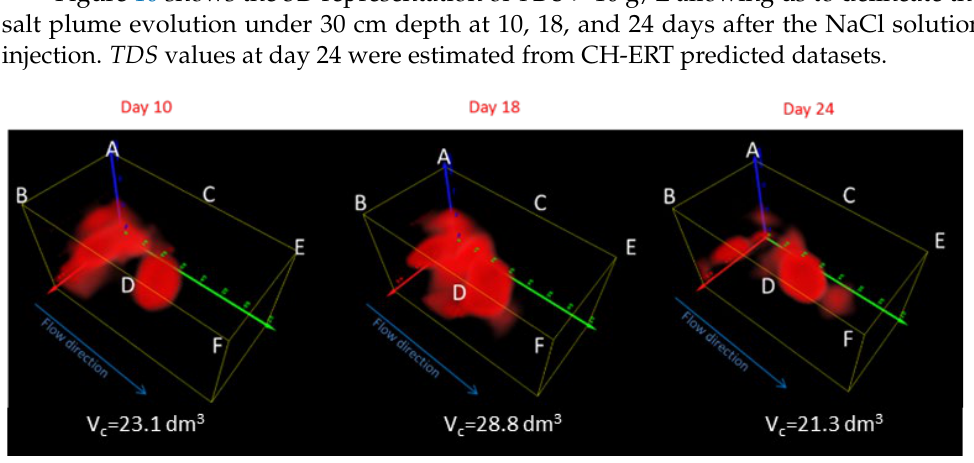
Figure 10. In red is the 3D distribution of TDS > 10 g/L obtained from predicted CH-ERT. A–F are piezometers, V c is the contaminated volume. TDS values at day 24 were estimated from CH-ERT predicted datasets. The 3D distribution was obtained with Paraview software (version 5.6.0, Kitware, Sandia National Labs, Los Alamos nat. lab., ASC and ARL, https://www.paraview.org/, accessed on 13 June